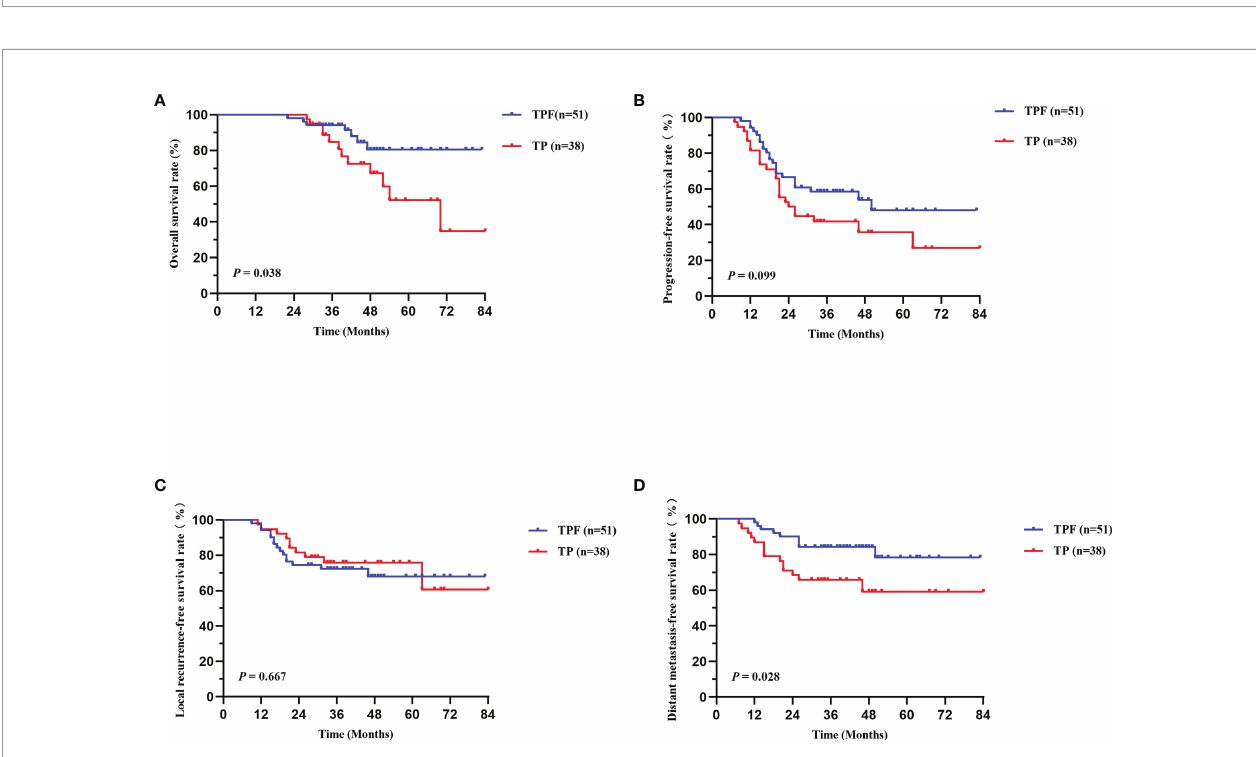
FIGURE 4 | Kaplan-Meier survival curves of OS (A) , PFS (B) , LRFS (C) , and DMFS (D) between TPF and TP groups in stage IVA patients with high SII (SII ≥ 432.48). TPF, docetaxel, cisplatin, and 5- fl uorouracil; TP, docetaxel and cisplatin; OS, overall survival; PFS, progression-free survival; LRFS, locoregional relapse-free survival; DMFS, distant metastasis-free